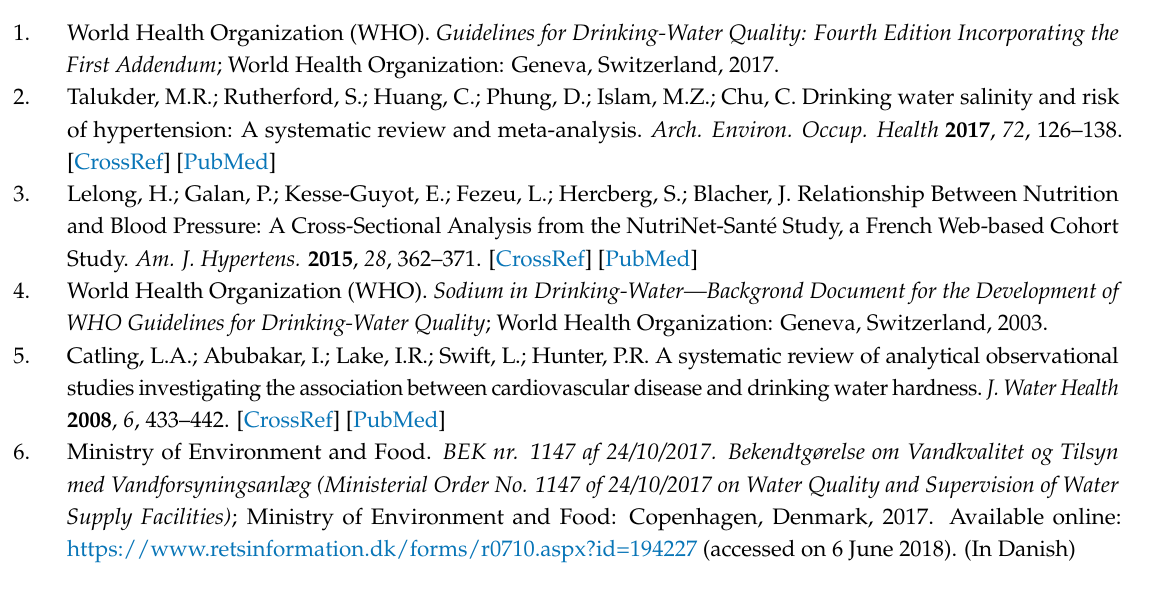
Figure S1: Workflow, Figure S2: Description and selected illustrations of the different trends in concentration, Table S1: Statistical significant clusters, Table S2: Comparison between number of waterworks and trend in